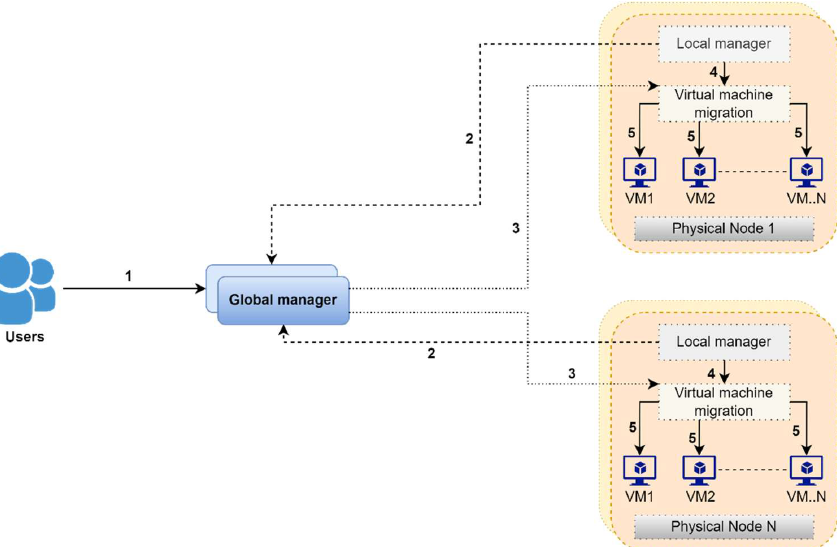
Figure 3. Overall System Methodology. 1 defines the user type as a global user and each node communicates to the global manager through its local manager represented by 2. Each node is divided into the number of VMs represented as 5 that are managed by their local manager for migration presented by 4. The global manager issues commands for the optimisation of the VM assignments shown in 3.